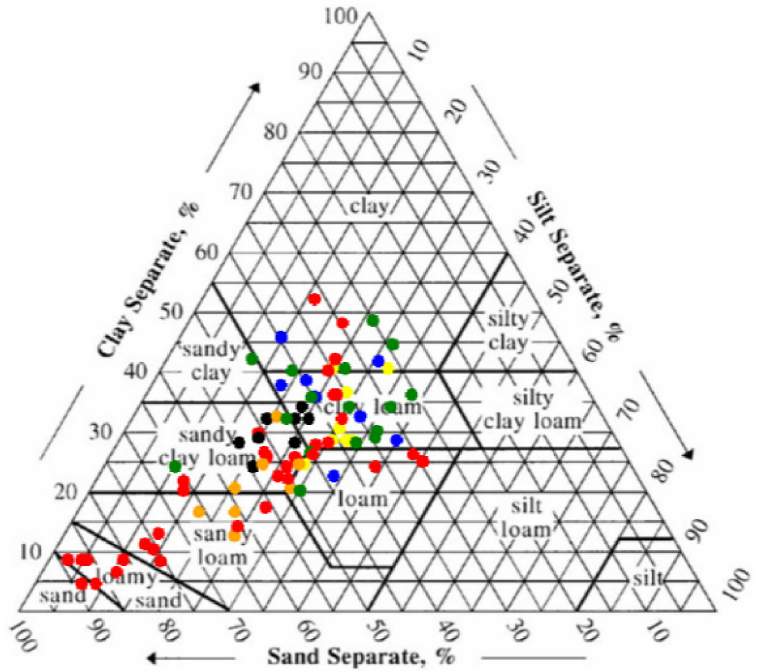
Figure 3. Distribution of soil texture in the Yinna mountainous area(different colors represent soil samples from different sampling